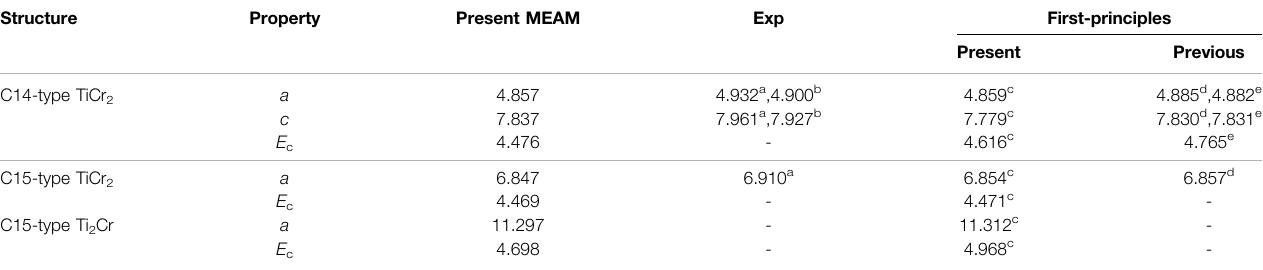
TABLE 5 | Comparison of the present 2NN MEAM lattice parameters and cohesive energies of the Laves phase C14-, C15-type TiCr 2 and C15-type Ti 2 Cr with other calculation results. The units of the lattice parameter a and the cohesive energy E c are Å and eV, respectively. Structure